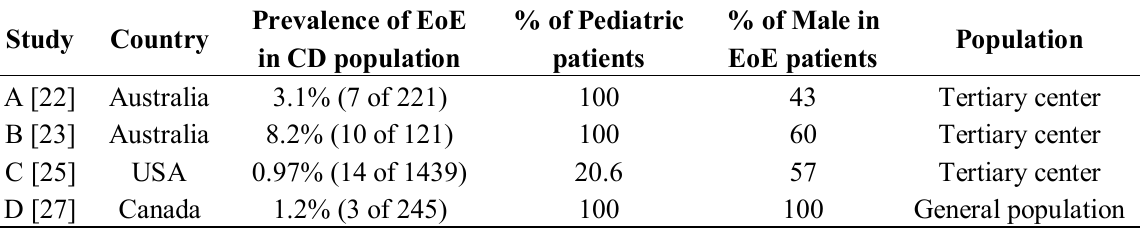
Table 1. Published study about prevalence of eosinophilic esophagitis (EoE) in patients affected by celiac disease